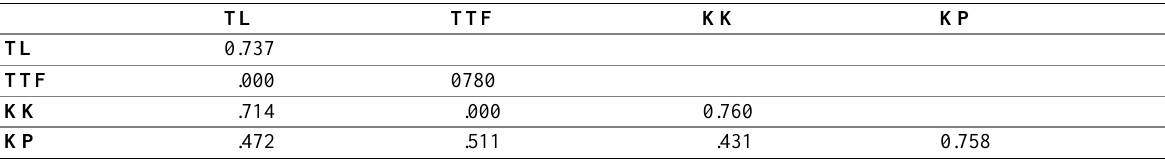
Table 1: Implied (for all variables)